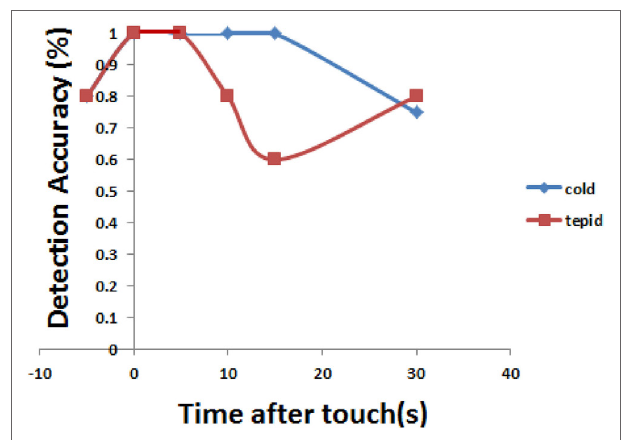
FigUre 14 | Comparison of accuracies for cold and tepid